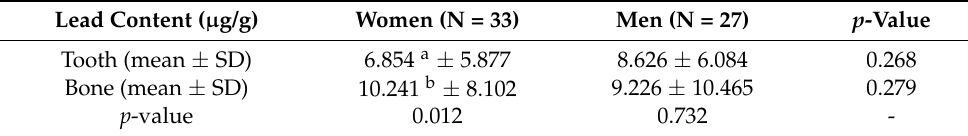
Table 7. Lead content in tested samples taken from patients of different sexes.